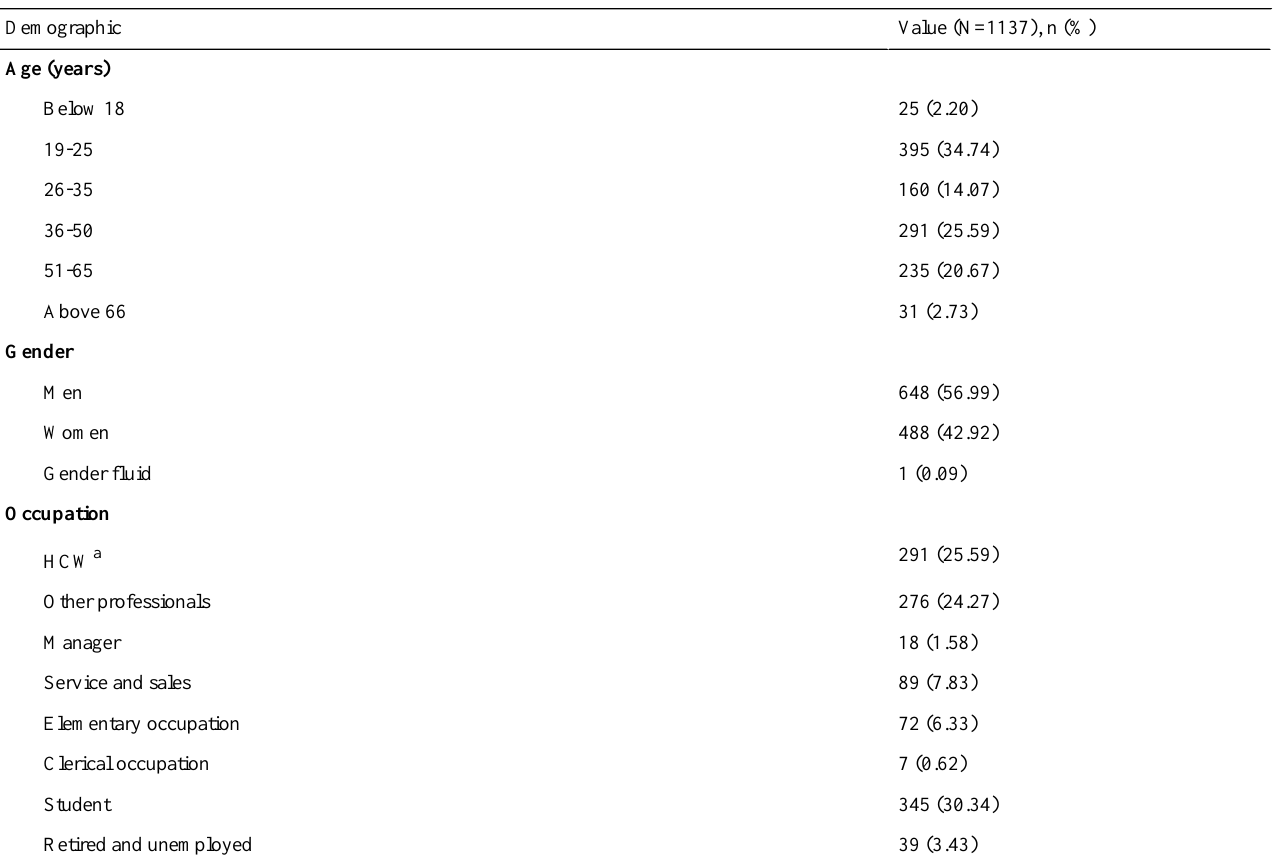
Table 2. Demographic characteristics of the study